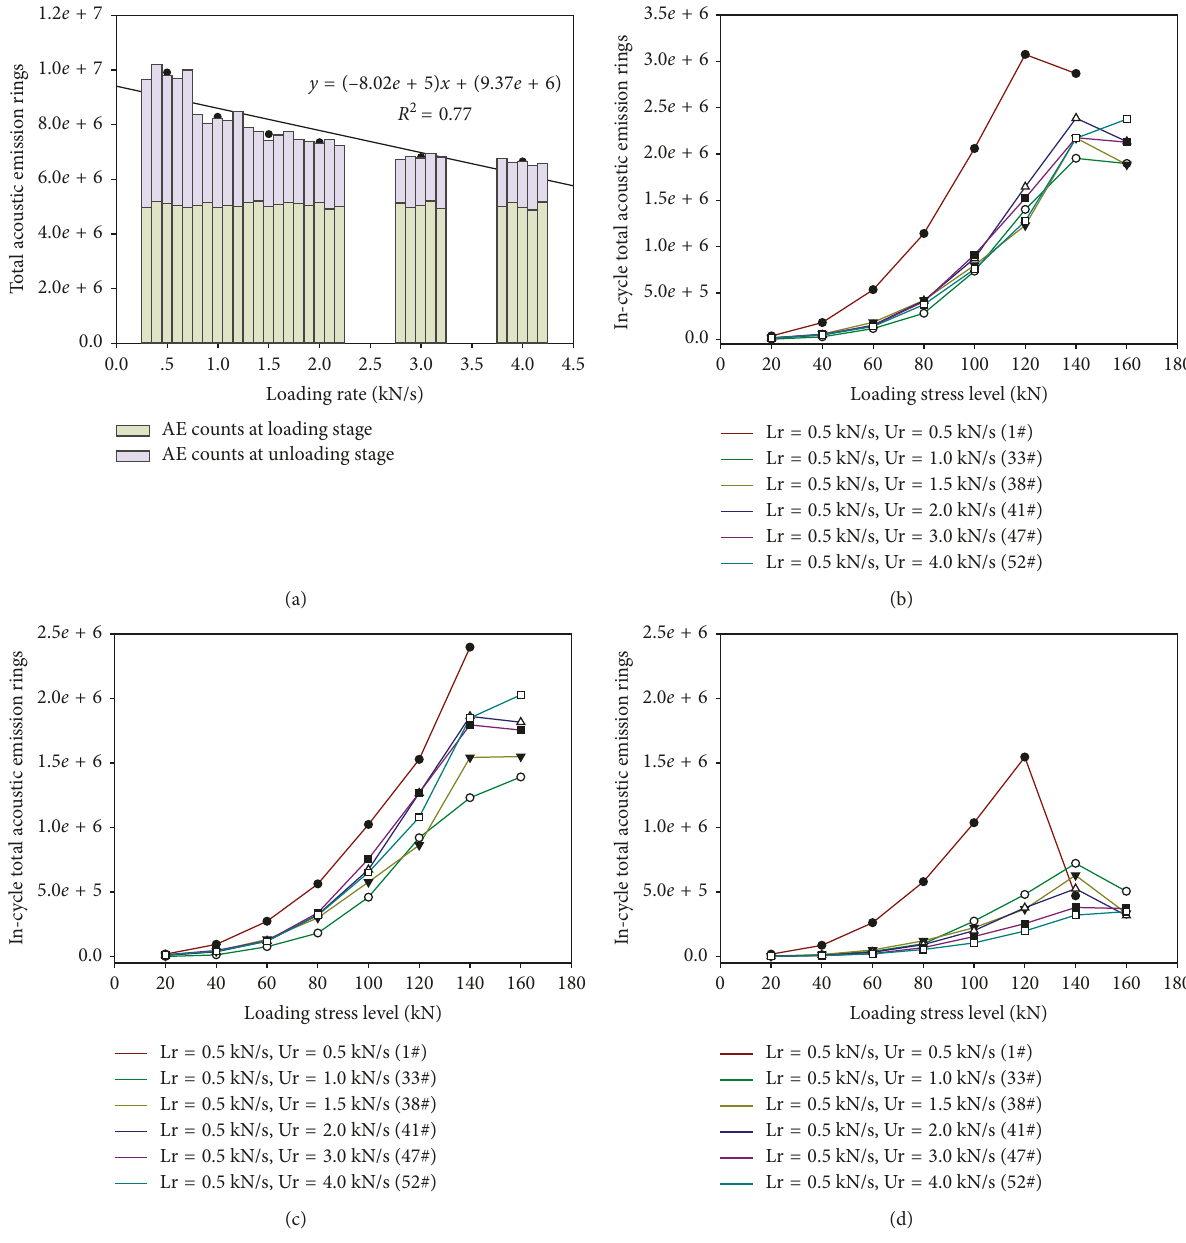
Figure 9: Variation of the AE characteristics of red sandstone specimens (Lr loading rates; (b) total AE rings of each cycle versus loading stress levels; (c) total AE rings at the loading stage of each cycle versus loading stress levels; (d) total AE rings at the unloading stage of each cycle versus loading stress